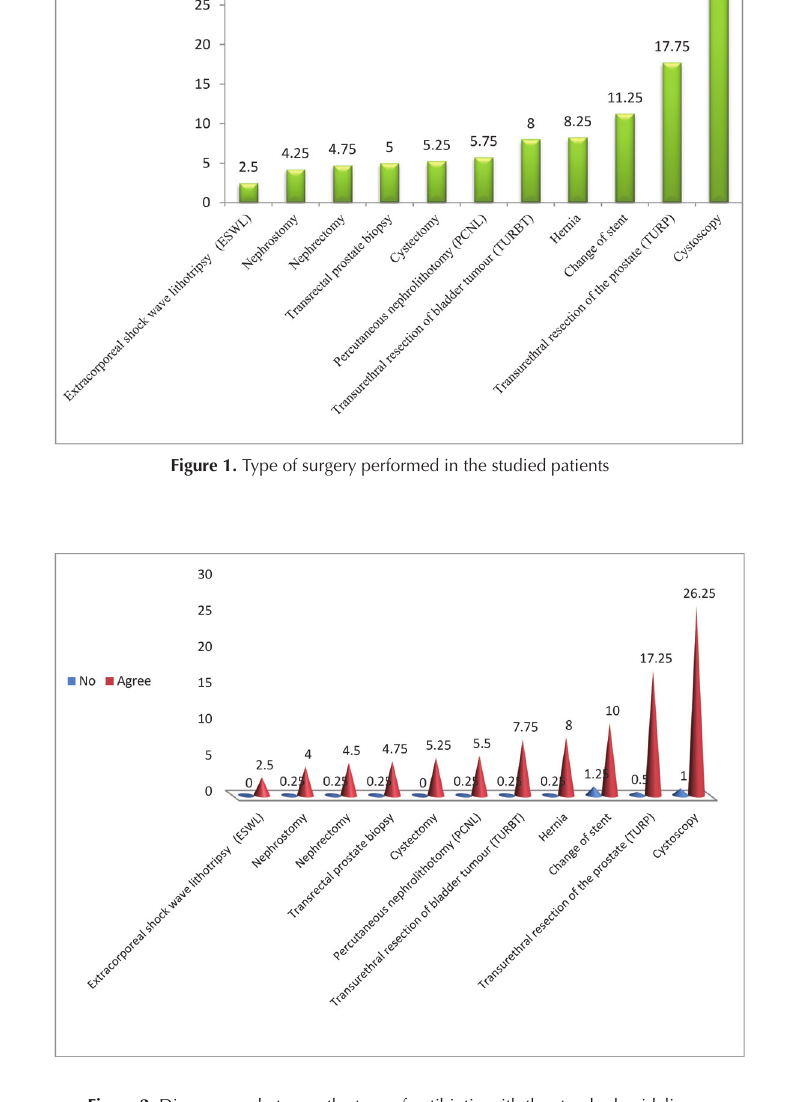
Figure 2. Discrepancy between the type of antibiotic with the standard